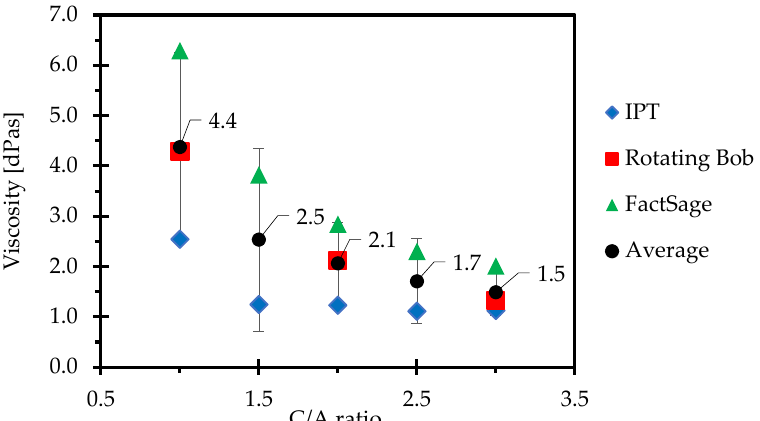
Figure 17. Comparison of measured and estimated viscosity of C-series mould powders at 1300 °C.